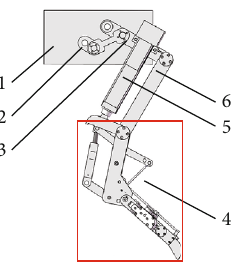
Figure 5: Mechanical leg for testing the bionic mechanical foot: (1) T-plate, (2) motor transmission shaft, (3) imitated femur structure, (4) bionic mechanical foot, (5) actuator of the foot, and (6) imitated tibia